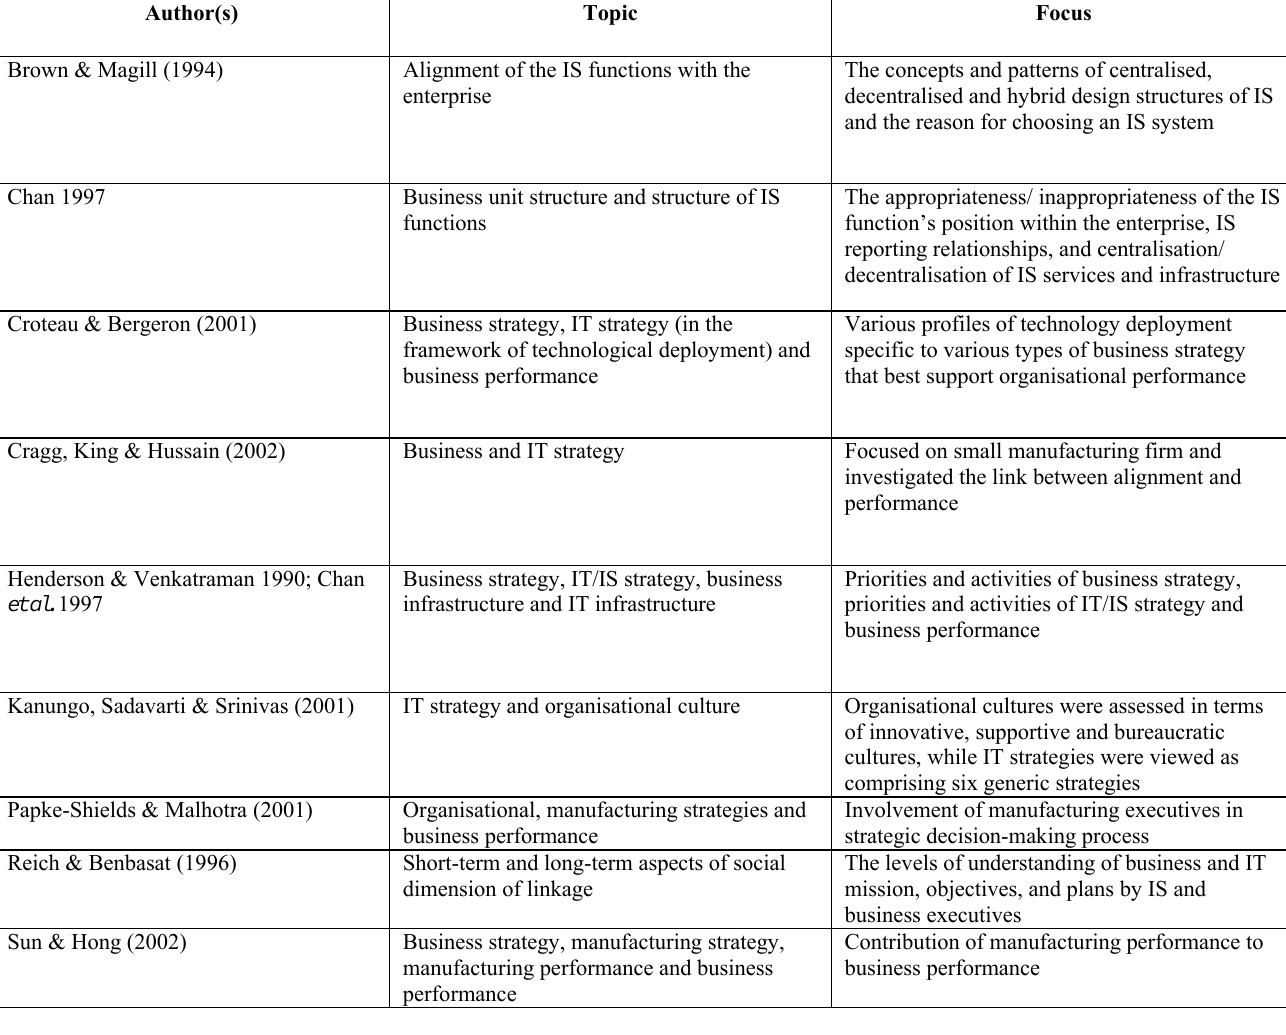
Table1: Studies on alignment